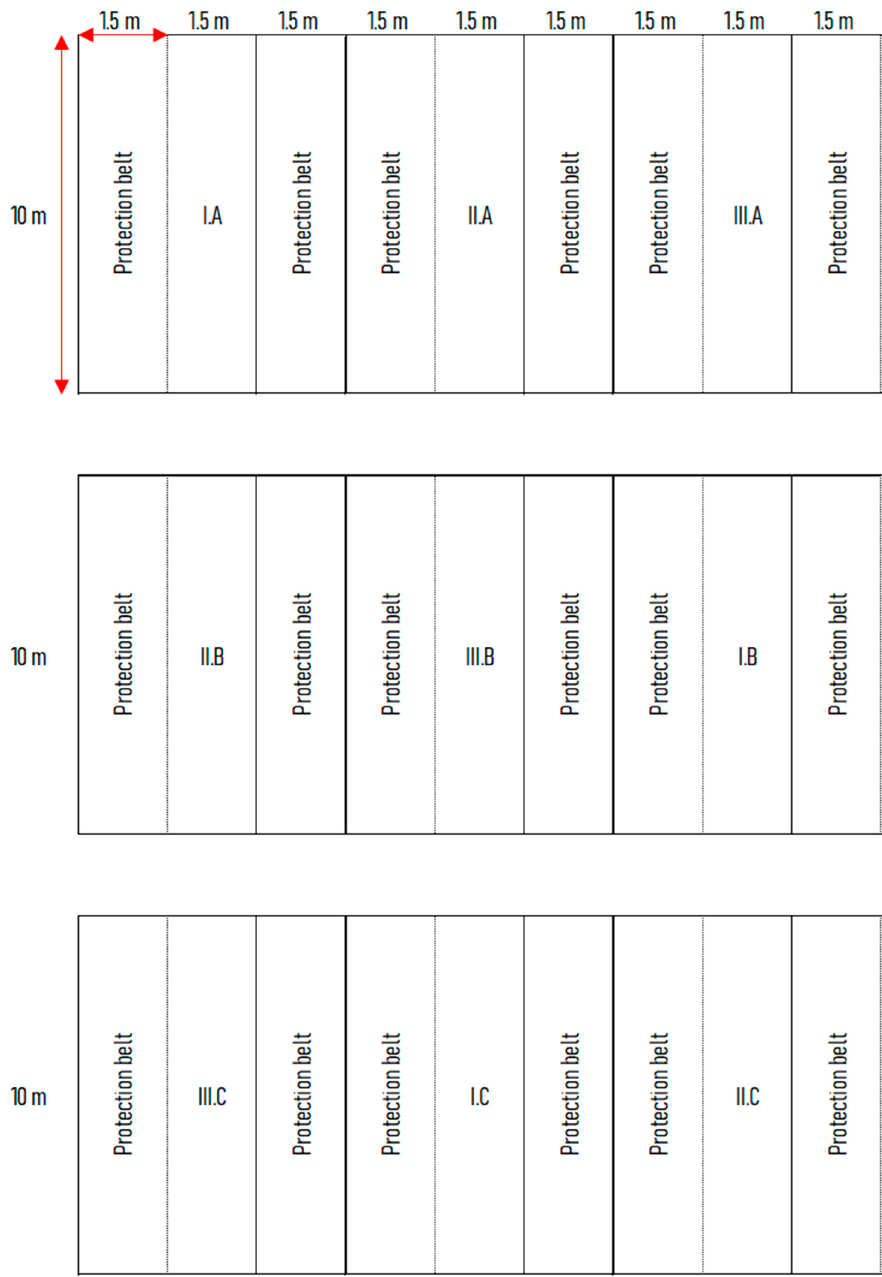
Figure A11. Organization of the field experiment: I (A,B,C)—Sowing 1 (1st half of April); II (A,B,C)—Sowing 2 (2nd half of April); III (A,B,C)—Sowing 3 (May).